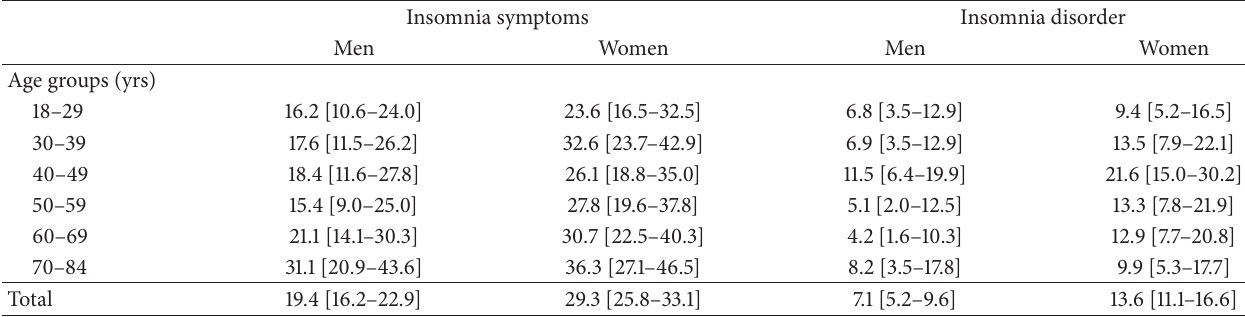
Table 2: Prevalence (%) and odds ratios (95% confidence interval) of insomnia symptoms and insomnia disorder by age groups in men ( 𝑛 = 537 ) and women ( 𝑛 = 587 ).